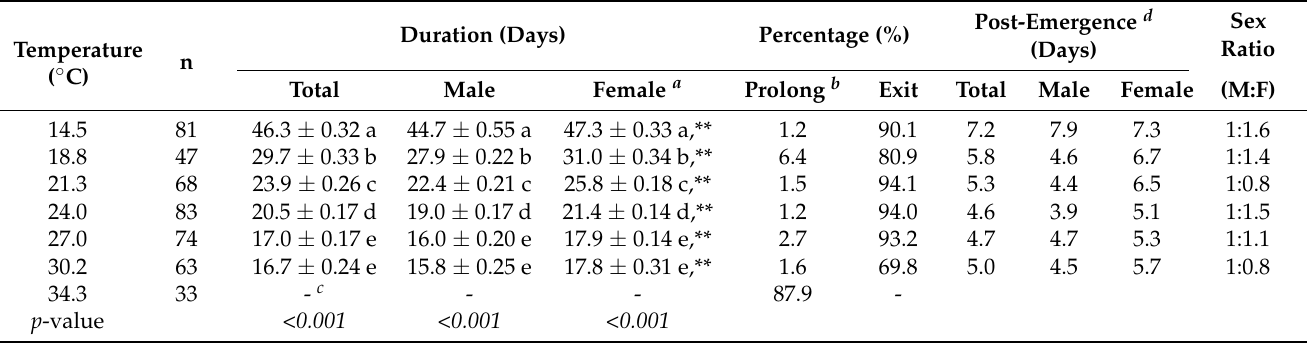
Table 3. Mean ( ± SE) developmental duration of the post-diapause periods of Eurytoma maslovskii until adults exited from their hosted apricot seed at various